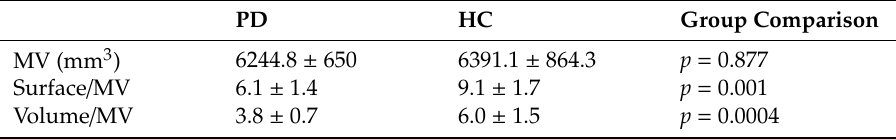
Table 3. Normalized results of surface and volume of the substantia nigra.